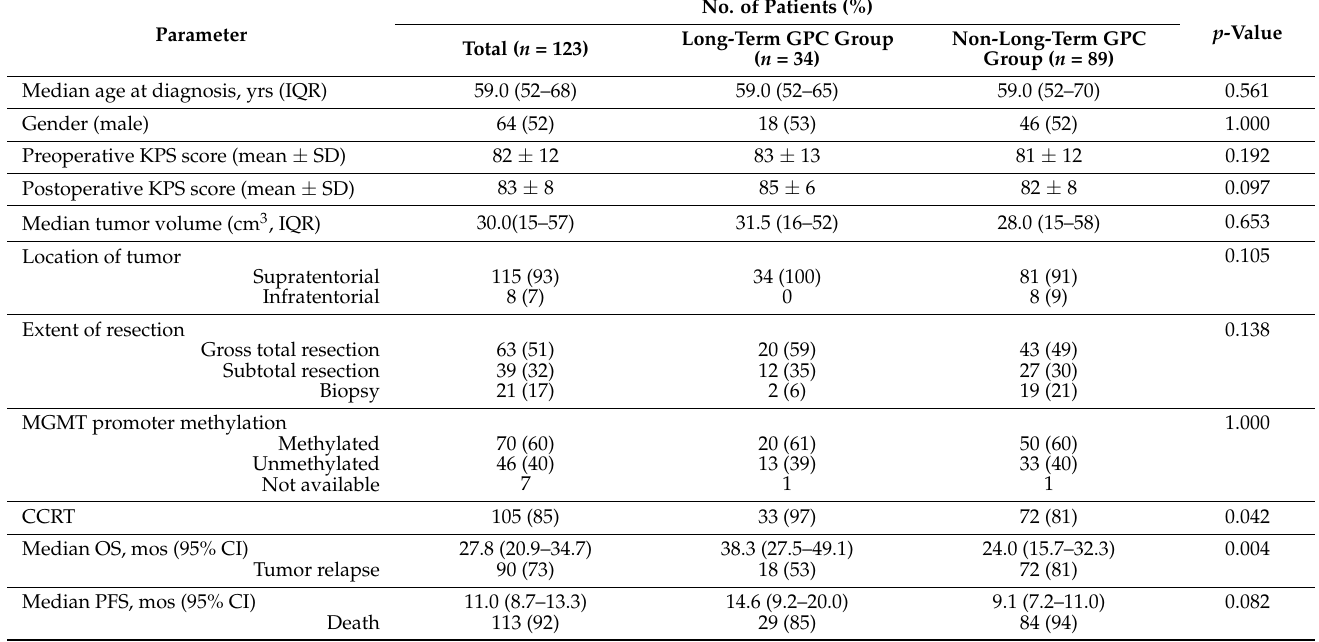
Table 3. Patient demographics according to the long-term use of GPC ( ≥ 12 mos) ( n =